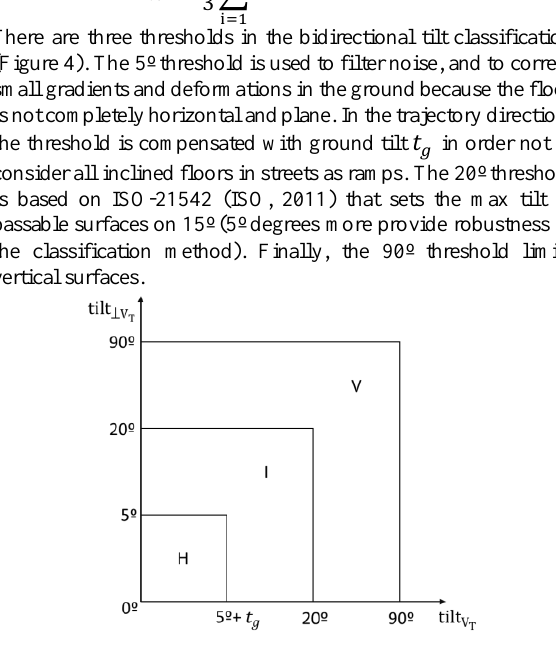
Figure 4. Bidirectional thresholds in the classification of points with an associated tilt horizontal-H, inclined-I and vertical-V.